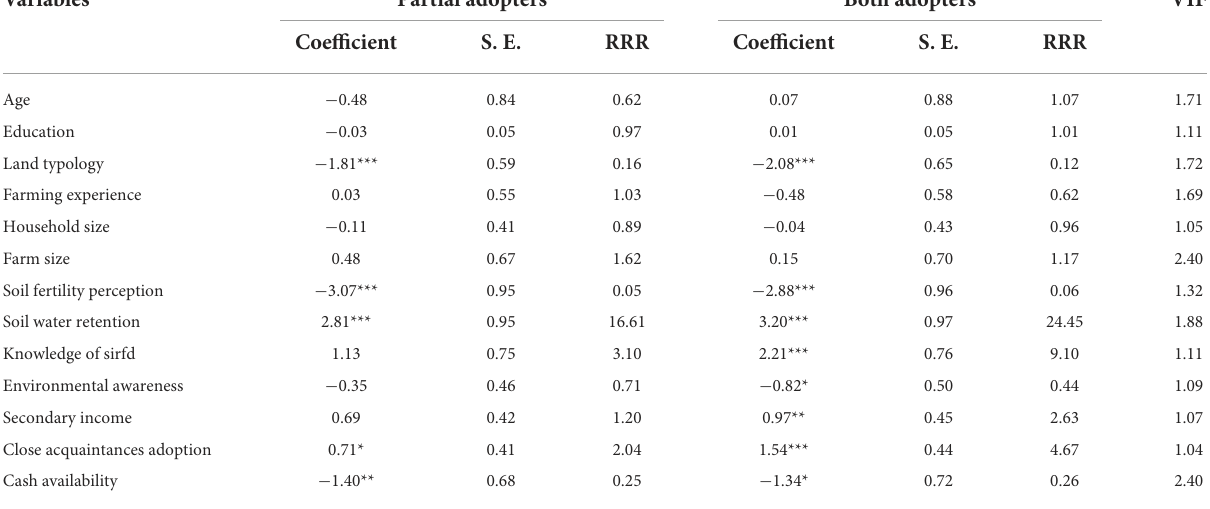
TABLE 3 Factors affecting the adoption of